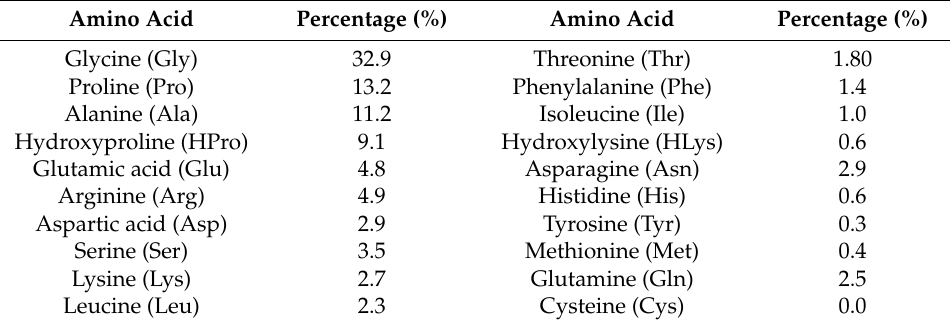
Table 1. Amino acid composition of gelatin strands [55].